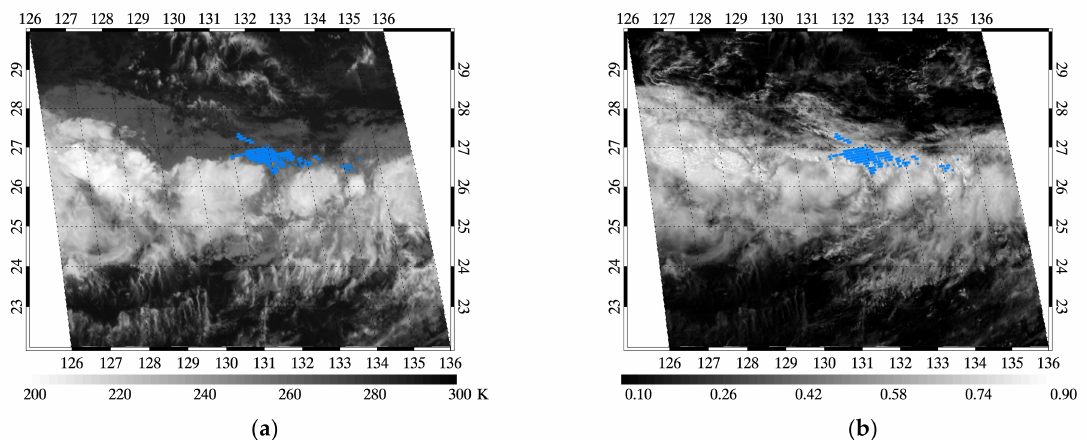
Figure 9. TROPOMI cloud pixels (AHI TB 10.4 > 260 K, TROPOMI R 0.354 > 0.9) plotted as blue dots on ( a ) 2-km AHI TB 10.4 and ( b ) 2-km R 0.47 images (20 June 2019 04:30